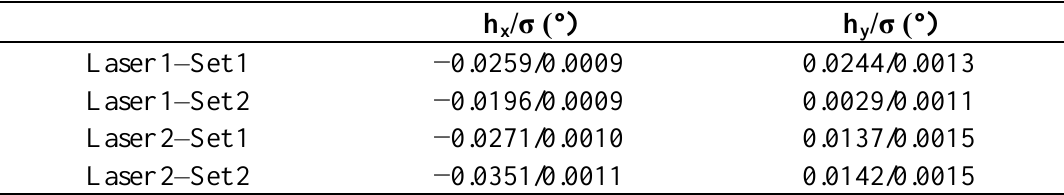
Table 3. Horizontal Encoder Non-Orthogonality Parameters for the Four Acquired